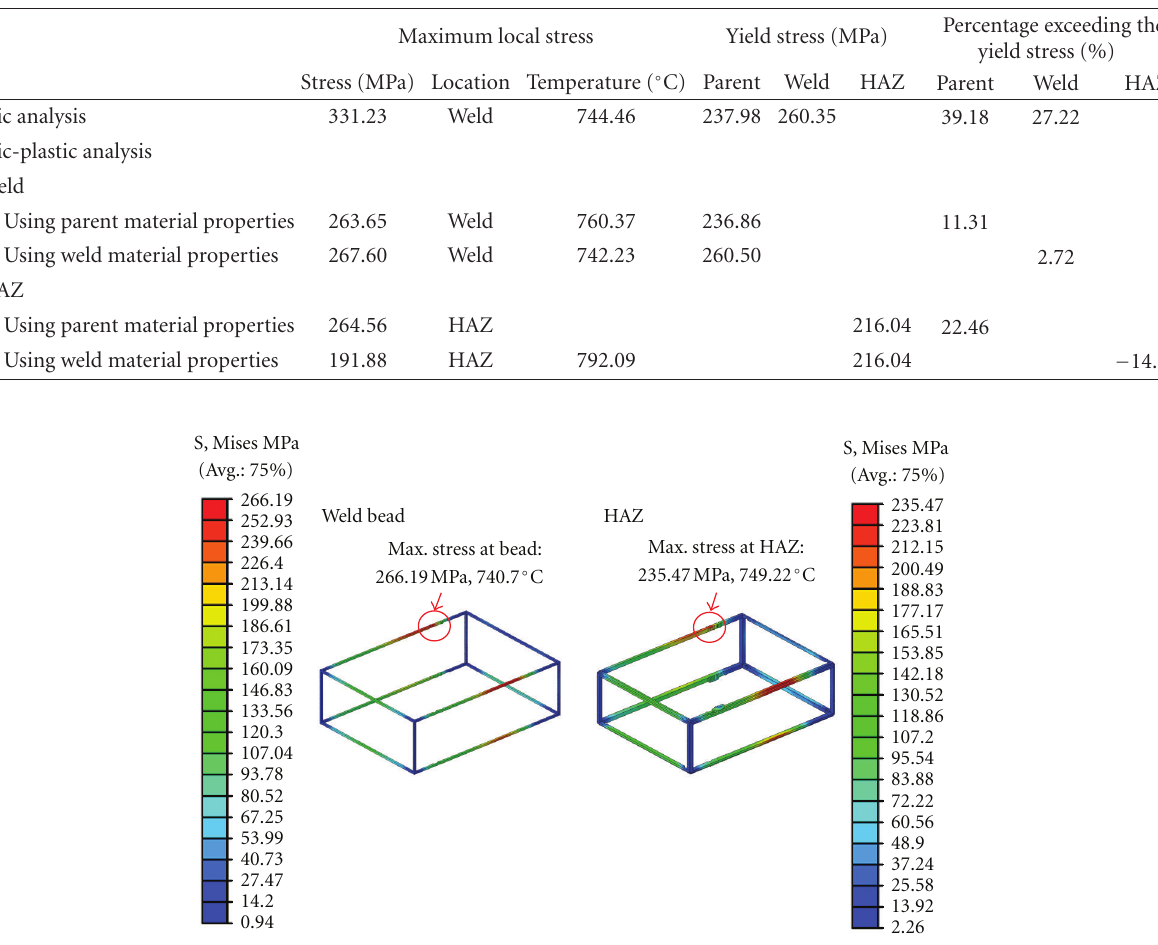
Table 6: Analysis results of 10 kW class PHE prototype.